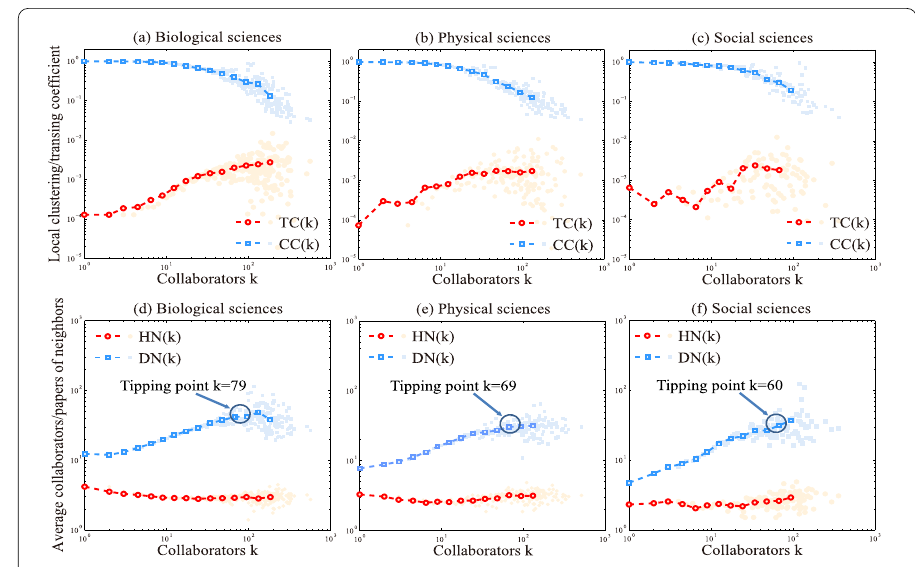
Figure 4 Conditional expected values of specific indexes given degree. From k = 1 to max( degree ), we average over k -degree nodes for local clustering coefficient ( CC ( k )), the local transitivity of collaborations ( TC ( k )), the average degree of node neighbors ( DN ( k )), and the average hyperdegree of node neighbors ( HN ( k )). The data are binned on abscissa axes to extract the trends hiding in noise